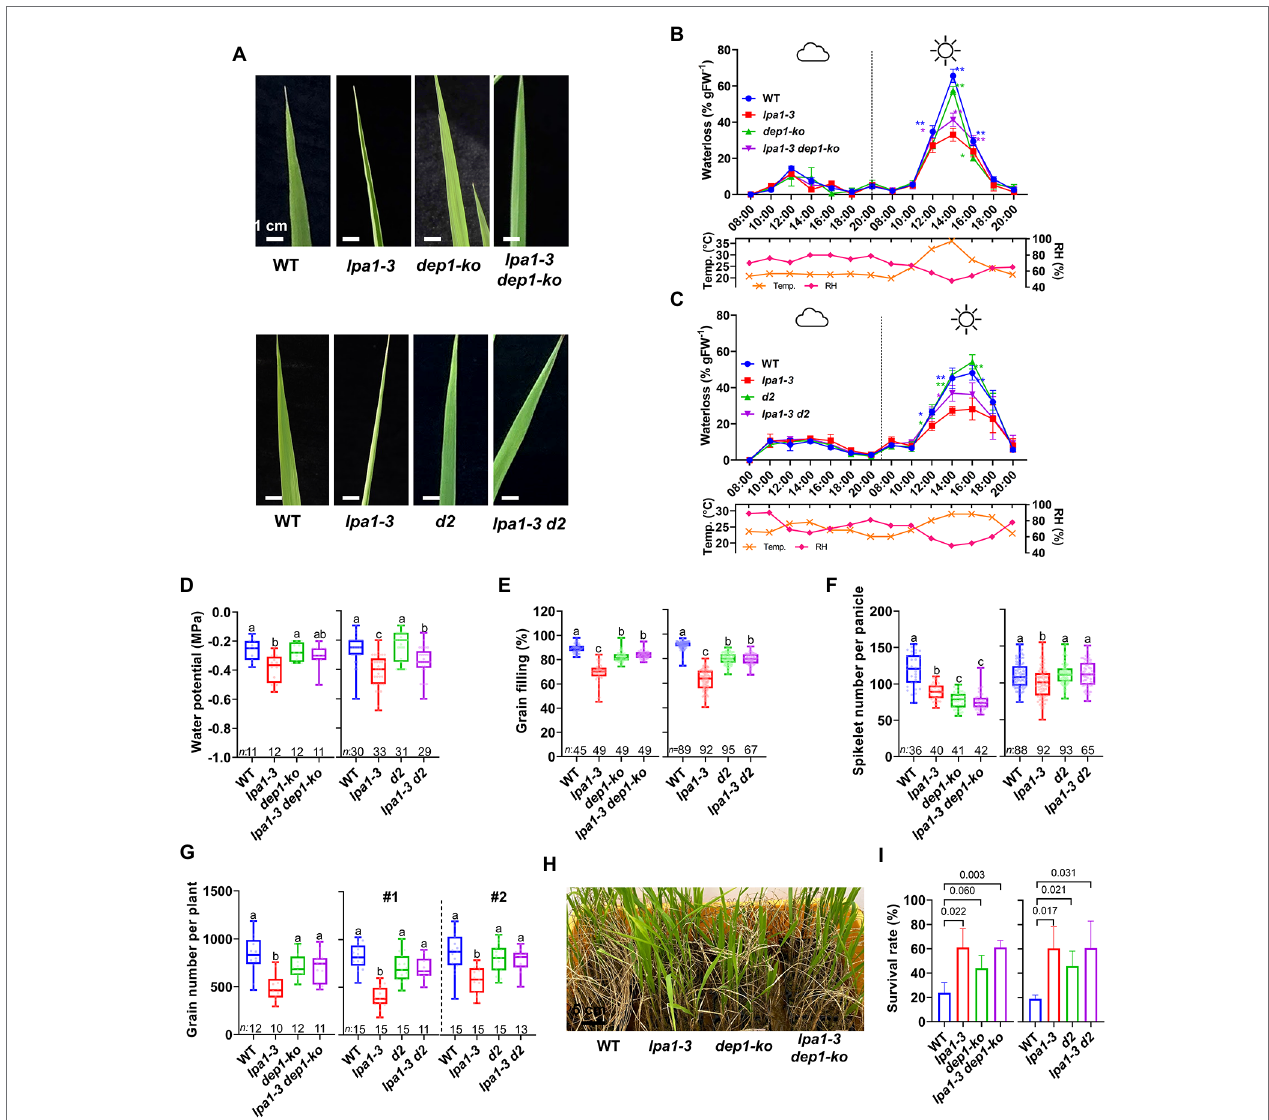
FIGURE 6 | Water use-related traits, grain yield, and drought tolerance of lpa1-3 dep1-ko and lpa1-3 d2 . (A) Representative leaf blade shapes among WT, lpa1-3, dep1-ko, lpa1-3 dep1-ko (top) and WT, lpa1-3, d2, lpa1-3 d2 (bottom) on sunny days. (B,C) Water loss assay of WT, lpa1-3, dep1-ko, lpa1-3 dep1-ko (B) and WT, lpa1-3, d2, lpa1-3 d2 (C) during cloudy and sunny conditions. Measured from a minimum of three replicates. * p < 0.05; ** p < 0.01; t -test. Temp., temperature; RH, relative humidity. (D–G) Quantification and comparison of water potential on sunny days (D) , grain filling rates (E) , spikelet number per panicle (F) , and grain yield per plant (G) among WT, lpa1-3, dep1-ko, lpa1-3 dep1-ko (left) and WT, lpa1-3, d2, lpa1-3 d2 (right). (H) Representative photographs of the surviving plants among WT, lpa1-3, dep1-ko, lpa1-3 dep1-ko after drought assay. (I) Survival rates of the drought resistance assay, quantified from three independent experiments, each consisting of 40–50 plants per genotype. All the genotypes are BC2F3 generation which are the progenies of segregation after backcrossing three times. Bar graphs display mean ± SD. For each box plot, the lower and upper bounds of the box indicate the first (Q1) and third (Q3) quartiles, respectively, the center line indicates the median. The different letters denote significant differences between samples by one-way ANOVA followed by Tukey’s post-hoc test ( p < 0.05). n , number of replicates. Scale bars are indicated in each